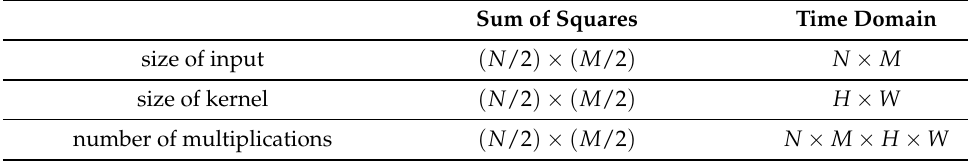
Figure 5. Five training results of Fashion-MNIST classification in frequency domain with the proposed nonlinear activation function, with square sum. The red color means the maximum accuracy, the yellow color is the minimum accuracy and the blue line shows the mean accuracy. Table 2. The table contains the number of multiplication in case of frequency-based implementation number of multiplications is 12,544 in Fourier domain and 451,584 in the time